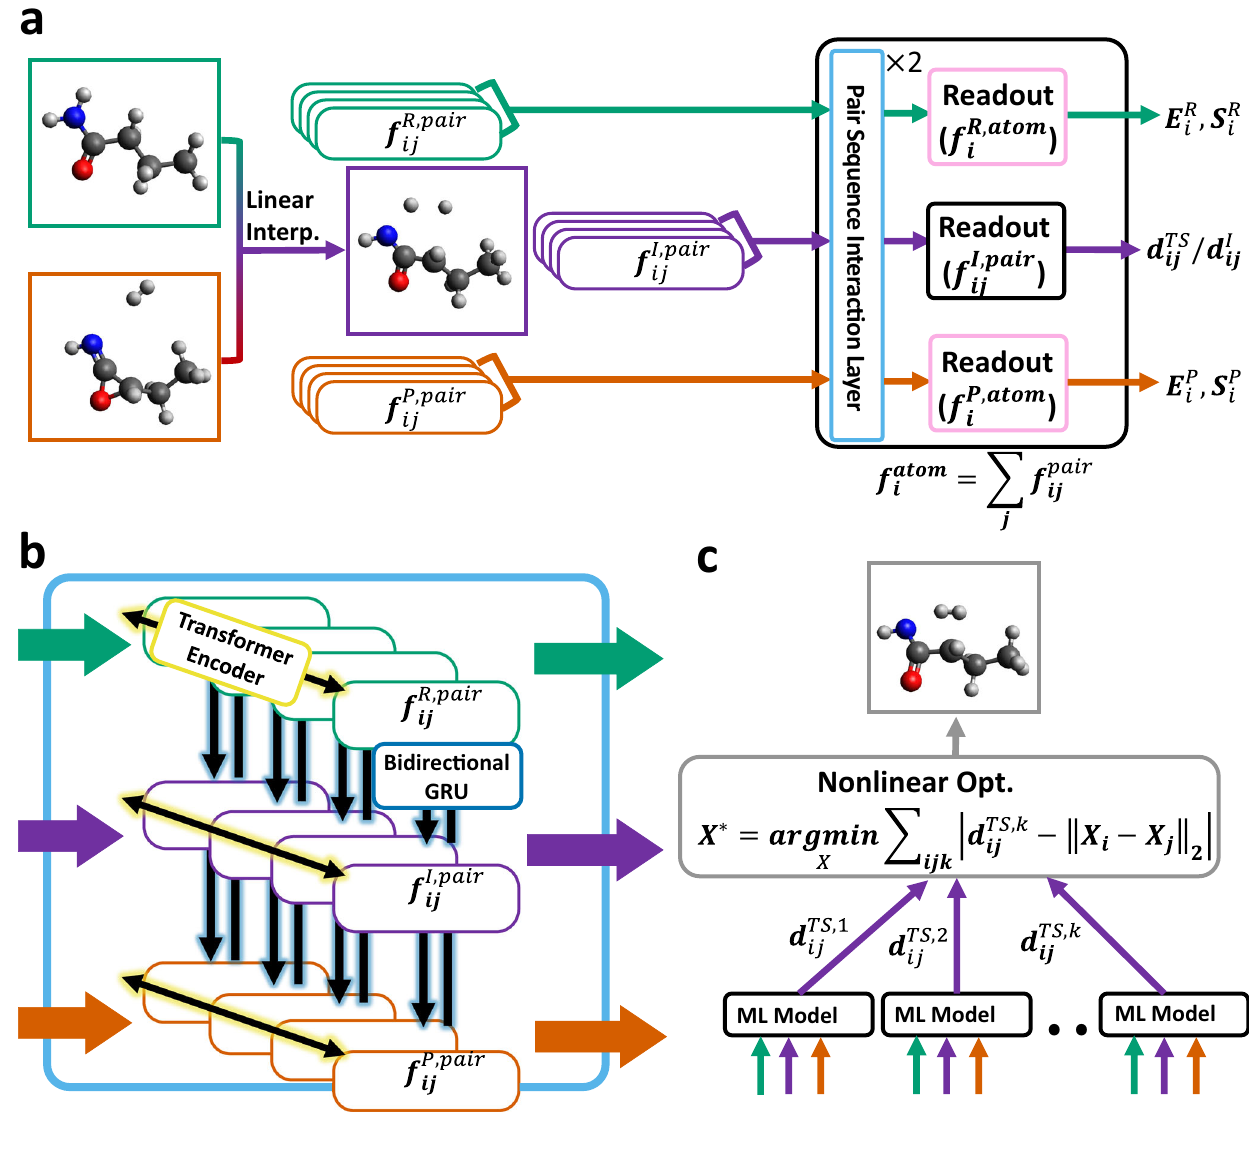
Fig. 1 | Schematic representations of machine learning (ML) models. a Overall MLprocedureutilizingreactant,product,andlinearlyinterpolatedstructures.Two different readout layers derive the molecular properties (molecular energy and entropy values, E and S ) and the ratio between interatomic distances of linearly interpolatedstructures, d I ij ,andtransitionstate, d TS ij ,fromthepairfeaturesofthree structures ( f R , pair ij : product). b Illustration of the pair sequence interaction layer consisting of transformer